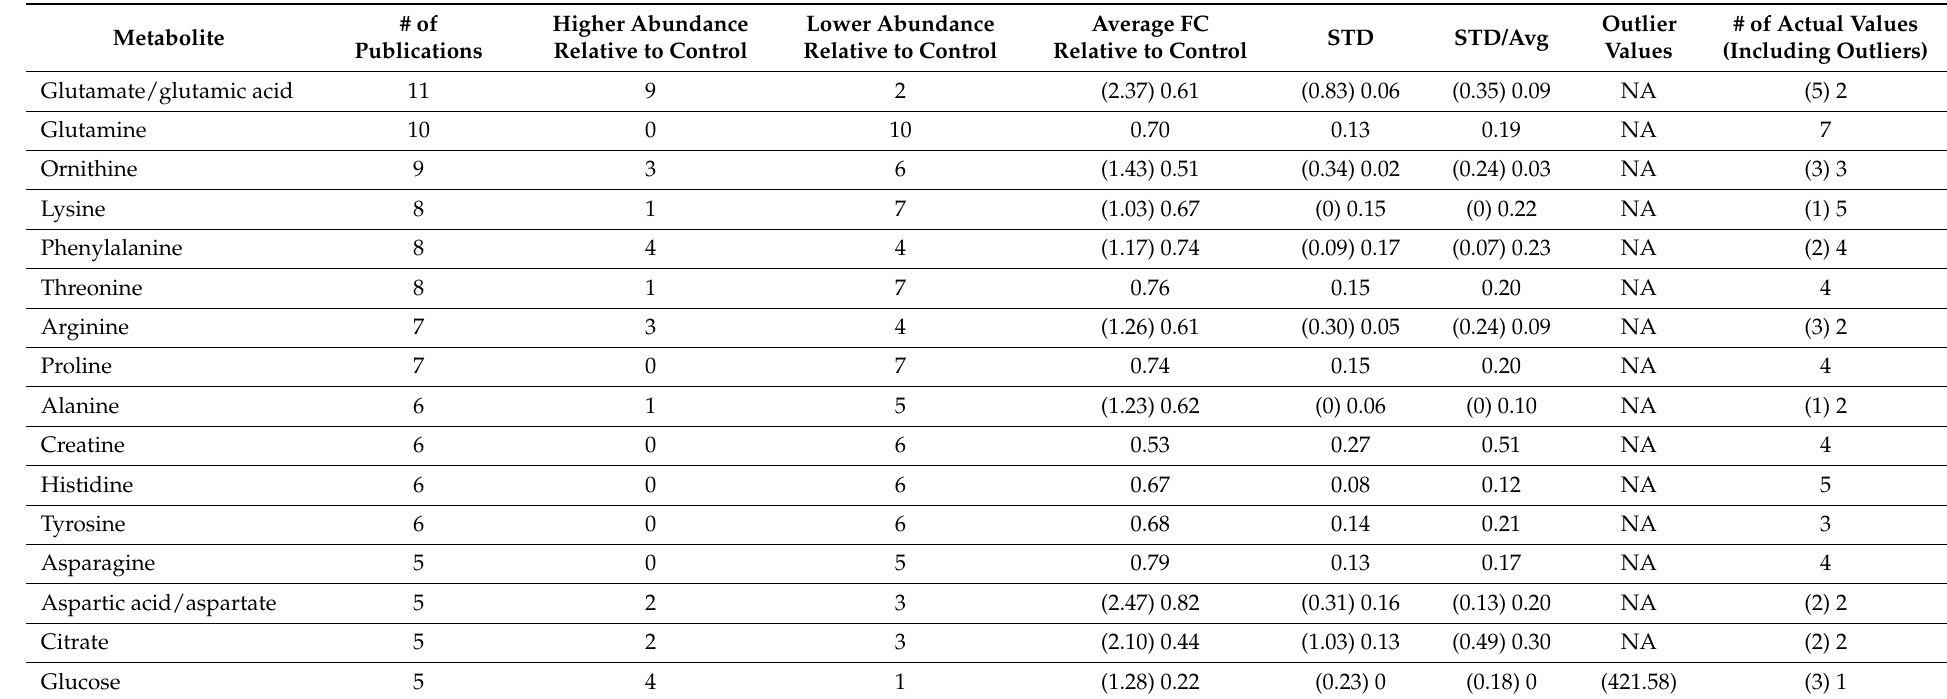
Table 3. Most Commonly Occurring Metabolites a